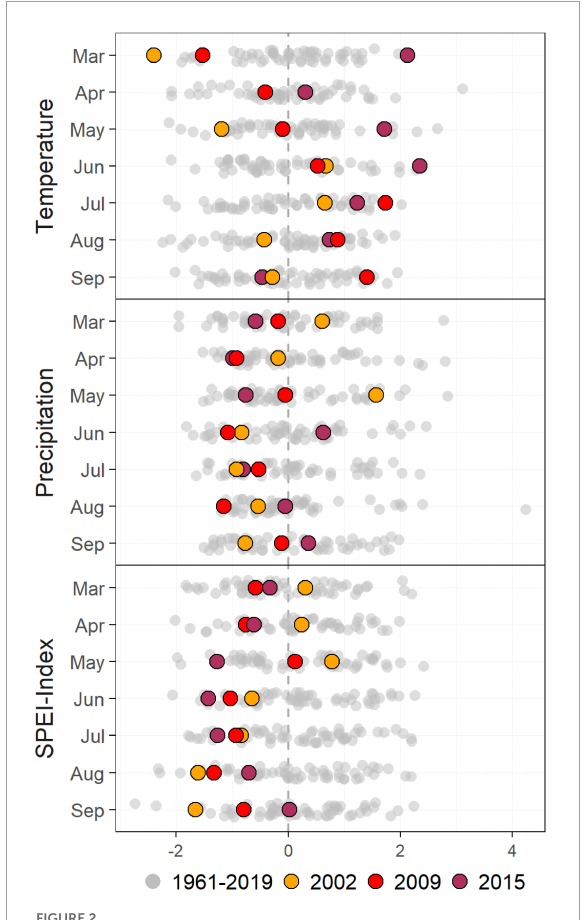
FIGURE2 Timeseries for temperature, precipitation, and the Standardized Precipitation-Evaporation Index (SPEI). Each dot represents a value in standard deviations for a particular year from 1961–2019. The drought years shortly before (2002), and after the tree removal treatment (2009 and 2015) are indicated in orange, red, and maroon. All other years are shown in